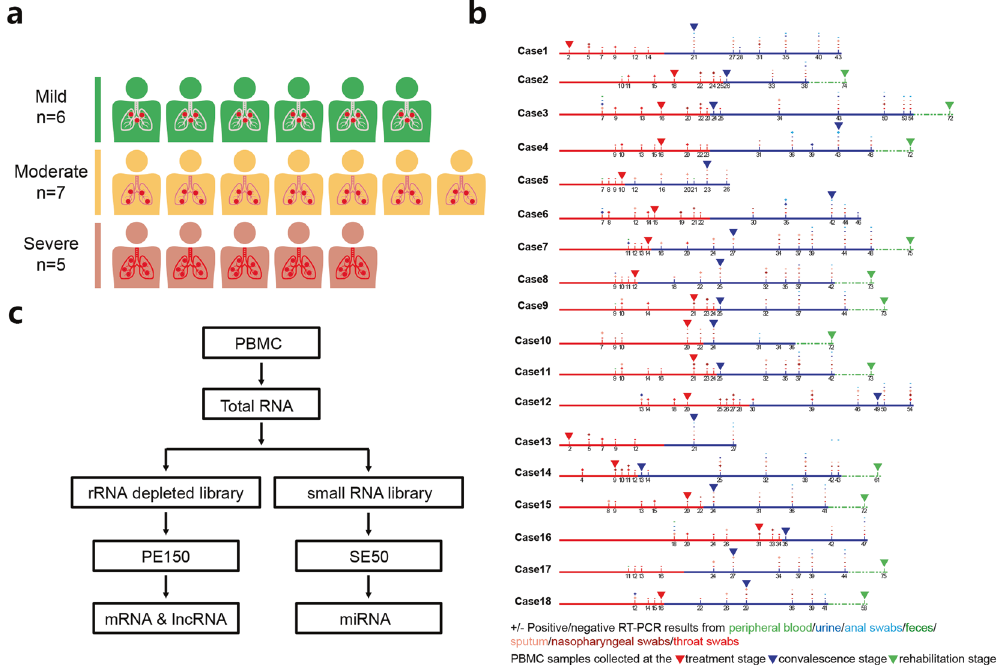
Fig. 1 Study design of whole transcriptome sequencing for PBMCs from patients with COVID-19 during recovery. a Patients are divided into mild, moderate and severe groups according to clinical symptoms of each one. b Timeline of the disease course of 18 patients infected with SARS-CoV-2. RT-PCR indicates the PCR test of SARS-CoV-2 nucleic acid. A positive RT-PCR (marked by “ + ” ) indicates that the SARS-CoV-2 nucleic acid was found in the throat swab, nasopharyngeal swab, sputum or other samples, which were distinguished by using different colors. “ − ” , negative RT-PCR. The solid red lines stand for treatment stage, solid blue lines for convalescence stage and doted green lines for rehabilitation stage. The sampling days were marked below this line. The inverted triangle symbol is used to mark the time point for collecting PBMC samples at each stage. c A fl owchart showing the process of library construction and RNA sequencing of PBMC samples from patients with